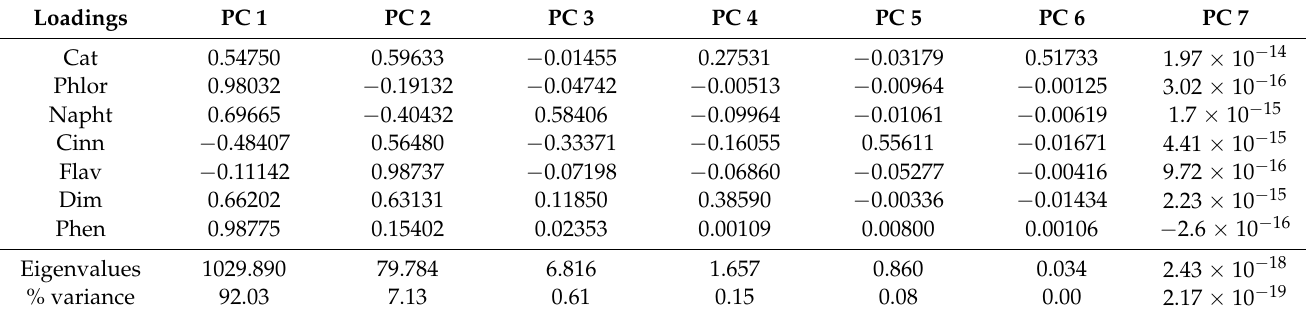
Table 5. Loadings, eigenvalues, and variance (%) accounted for by the 7 components found by PCA.